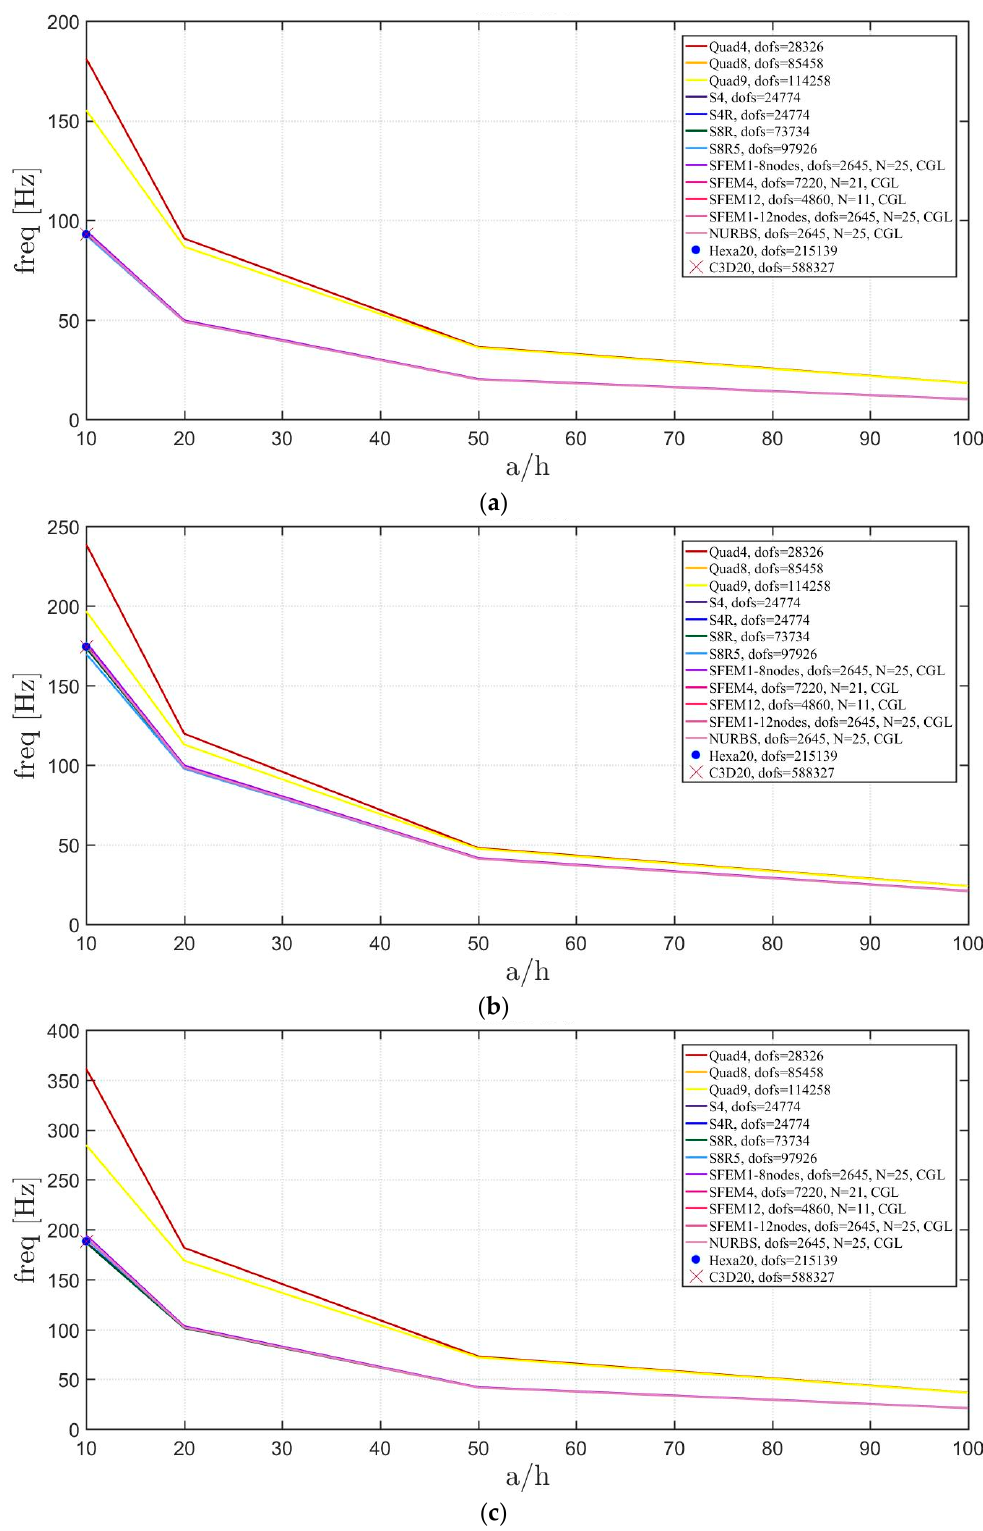
Figure 27. Thickness effect on the first three natural frequencies of an elliptic plate a / b = 2 with a symmetric lamination scheme: ( a ) First frequency; ( b ) Second frequency; ( c ) Third frequency.